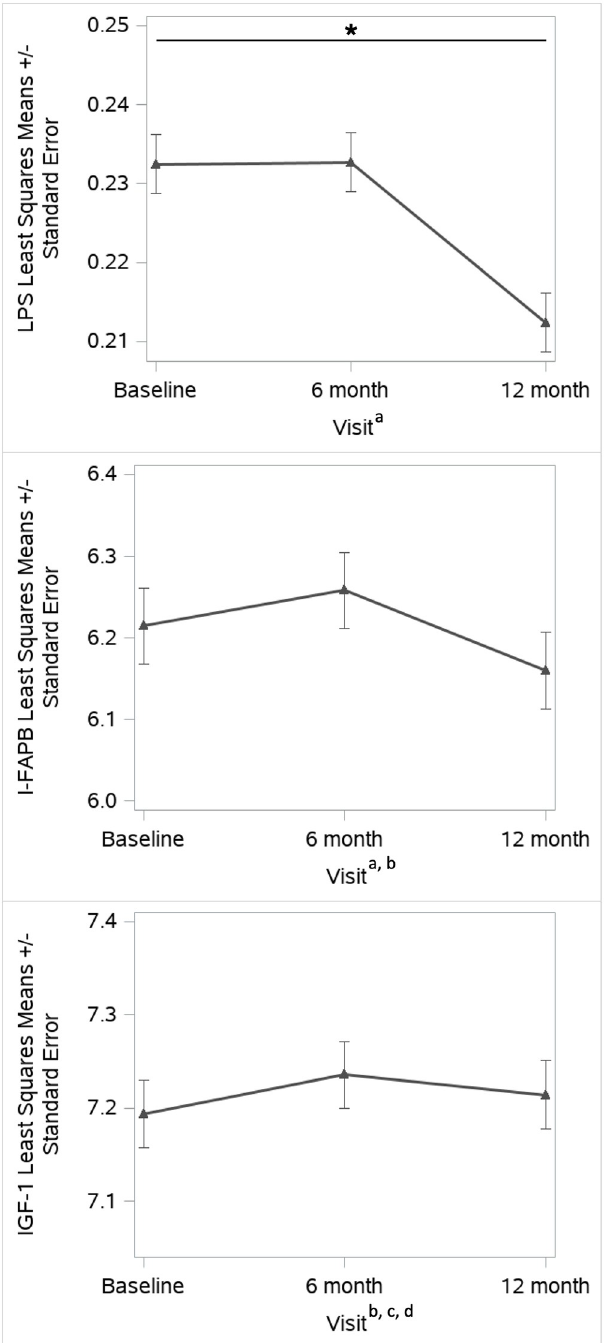
Fig 2. Biomarkers across visits. Least squares means and standard errors for lipopolysaccharide (LPS, EU/mL), intestinal fatty acid binding protein (I-FABP, pg/mL), and insulin-like growth factor 1 (IGF-1, pg/mL) concentrations across visits (baseline, 6-months, and 12-months). Asterisks represent significant differences determined by multivariate regression with the baseline visit as the reference category. Stepwise selection retained variables of a) WAZ, b) age, c) sex, and d) S . mansoni infection intensity category. Continuous variables were natural log- transformed.